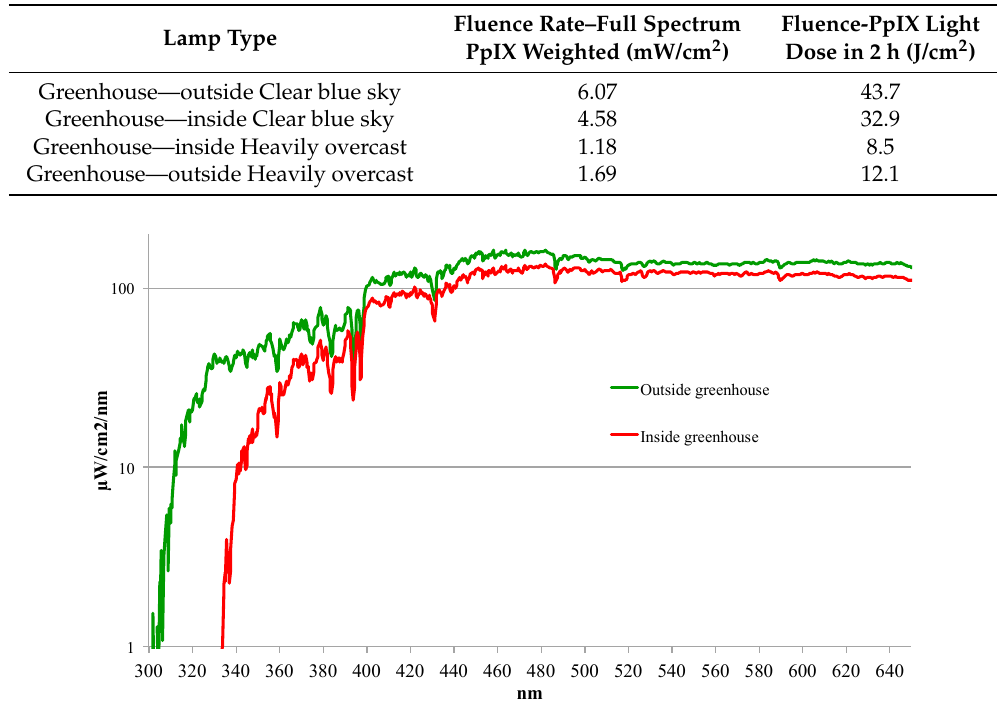
Figure 6. Spectra of daylight outside and inside the greenhouse–overcast (11 June 2015).